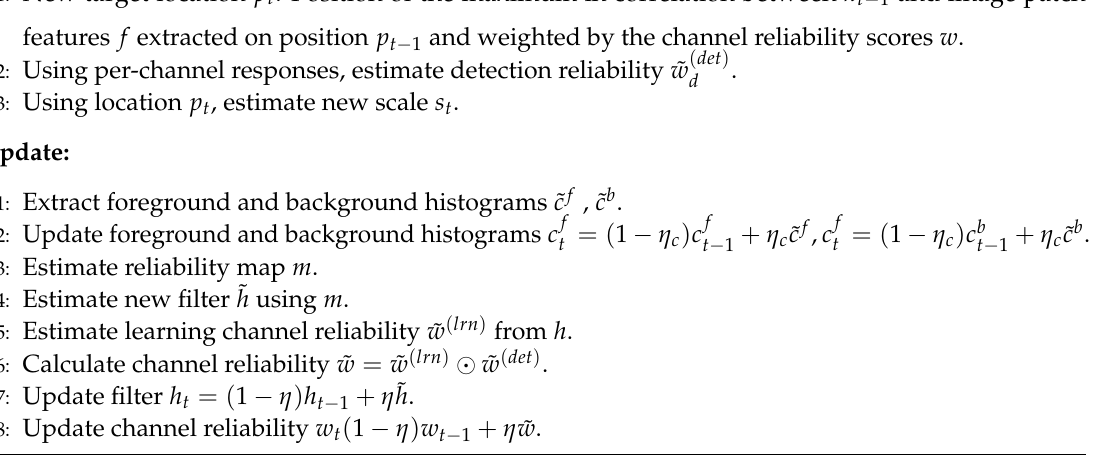
Algorithm 1 The CSR-DCF tracking